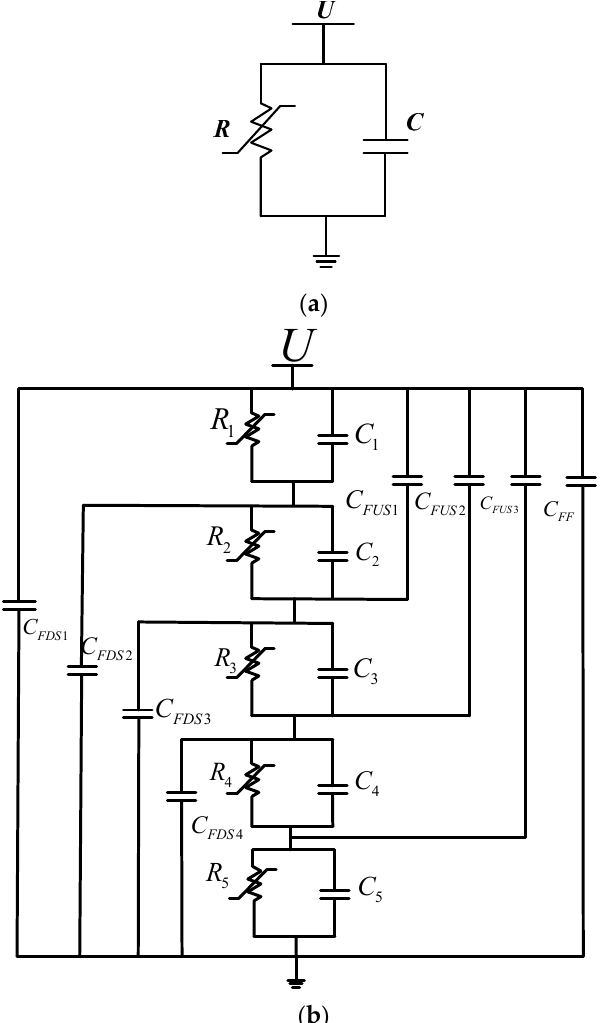
Figure 1. Conventional circuit model for ZnO varistor and metal-oxide arrester (MOA): ( a ) varistor model; ( b ) MOA model.